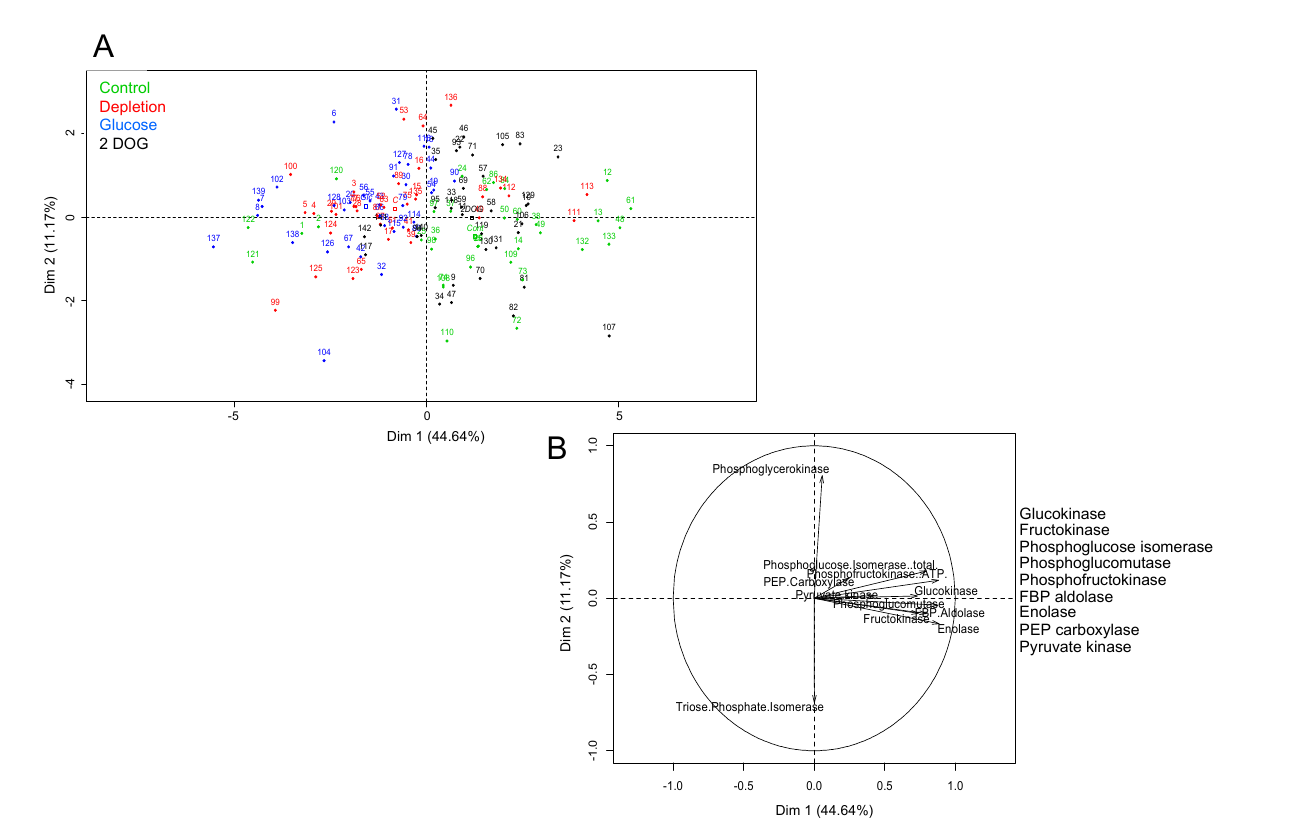
Figure 12. Principal component analysis (PCA) of measured enzyme activities in non-embryogenic WT and 35S::VvMSA-RNAi cells. ( A ) Individual map. ( B ) Correlation circles. The overall data of enzyme activity measurements were used. Studied conditions: Control-cells that were transfected in the complete GM + culture medium for 30 h or 48 h. Depletion-cells that were transfected in the minimal GM ◦ culture medium for 30 h or 48 h. Glucose and 2DOG-cells that were transfected in the minimal GM ◦ culture medium for 24 h and treated with 10 mM glucose or 0.9 mM 2DOG for additional time periods of 6 or 24 h. Three independent biological repetitions were carried out for each of the studied conditions, with at least three technical replicates per biological repetition. Green-control; red-depletion; blue-glucose; black-2DOG. VvMSA repression in non-embryogenic cells exerted a significant effect on the maximal activity of GluK and PGI ( p < 0.001), PGK ( p < 0.01), and PFK ( p < 0.05) (Table S1).